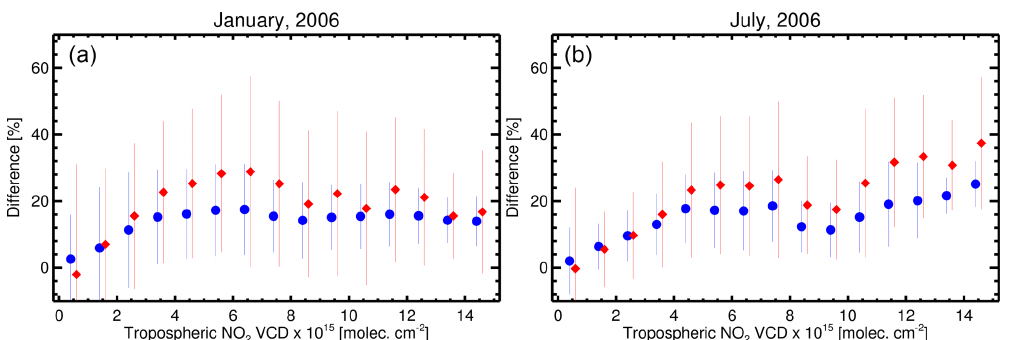
Figure 20. Difference in tropospheric NO 2 VCD caused by replacing climatological LER with GLER for July (a) and January (b) 2006. Surface reflectivity affects NO 2 retrievals directly as an input to the AMF calculation (blue symbols) and indirectly by changing cloud parameters used in the AMF calculation (red symbols). Vertical bars represent the standard deviation for each class of tropospheric NO 2 VCD of the size 1 × 10 15 moleccm − 2 . The standard deviations contain both effects of surface reflectivity on NO 2